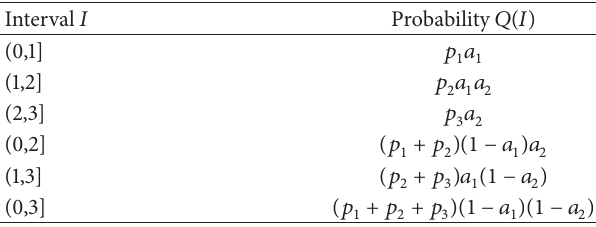
Table 1: The probability of selected interval. Table 2: Selection probability 𝑄(𝐼) for all admissible